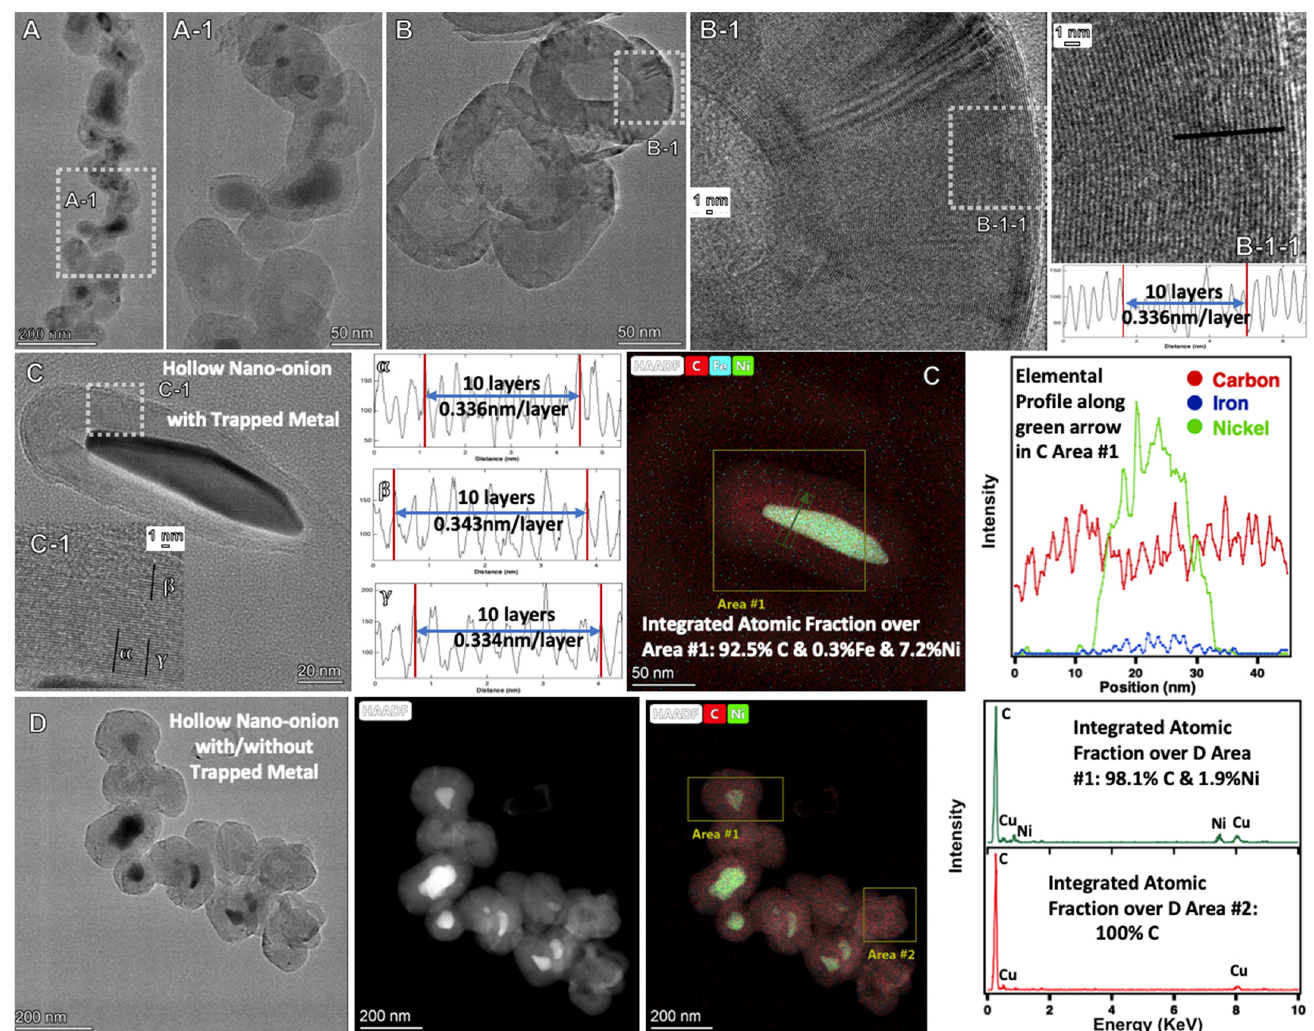
Figure 6. TEM and HAADF elemental analysis of the hollow nano-onion carbon allotrope synthesized by molten carbonate electrolysis. ( A ) and A-1: Hollow nano-onions with and without trapped metal. ( B ) and B-1: Hollow nano-onion without trapped metal. Note, measured graphene layer thickness is part of sub-figure B-1. ( C ) and C-1: Hollow nano-onion with trapped metal. Note, measured graphene layer thickncess and the elemental profile are part of sub-figure ( C ). ( D ); Hol- low nano-onion with and without trapped metal. Note, measured elemental HAADF and elemental analysis are part of sub-figure ( D ).